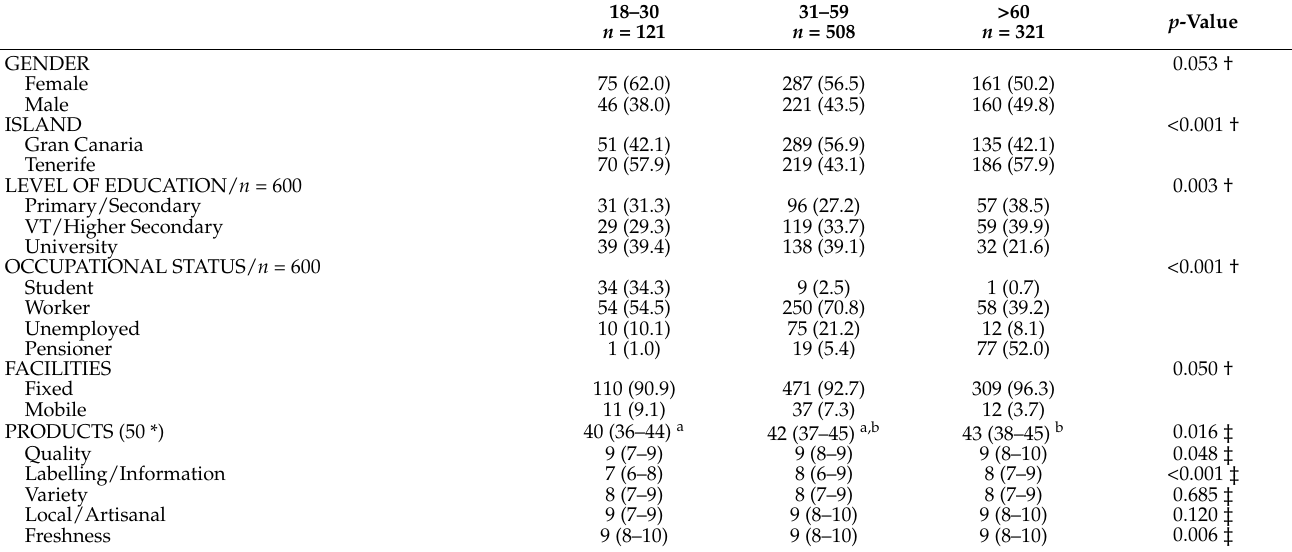
Table 2. Analysis of consumer age